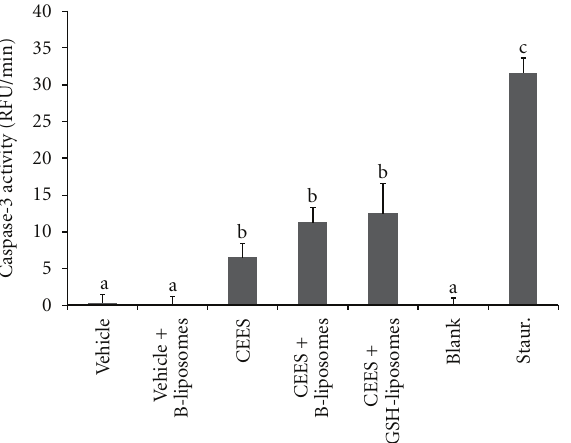
Figure 5: Protective e ff ects of GSH-liposomes or free GSH in EpiDerm (posttreatment) . EpiDerm tissues were exposed topically to 2.5 mM CEES or vehicle (1% DMSO) in the absence or presence of Blank liposomes (B-liposomes) or GSH-liposomes (as indicated) applied simultaneously with CEES or vehicle, but into the bottom media (sim: simultaneous application; post: 1 hour post-treatment). Final “calculated” concentration of GSH was 10mM (see Section